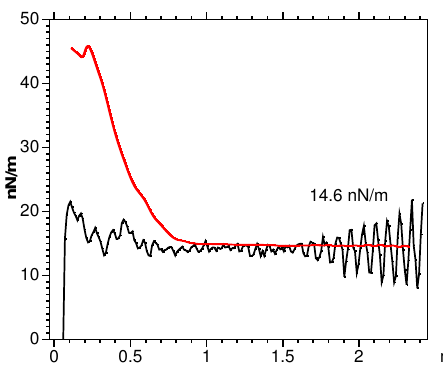
Figure 9. Run Helium: same as Fig. 2, but in helium plasma.